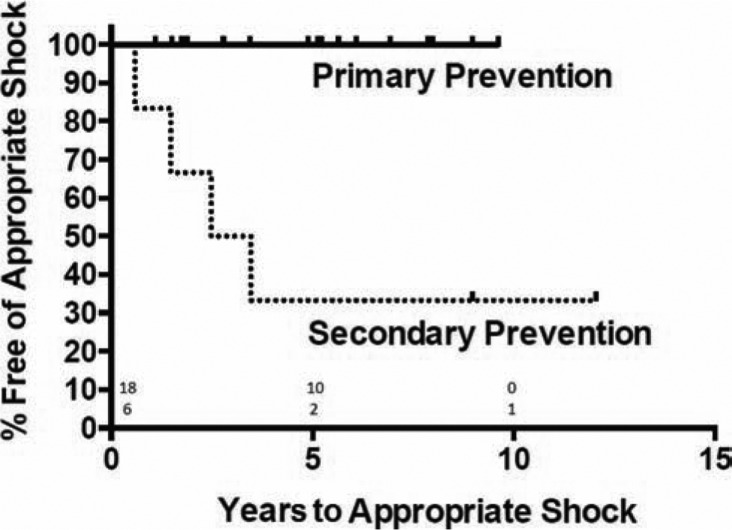
Time to appropriate shock following implantable cardioverter-defibrillators implantation. Median time to first shock for secondary prevention was 3.0 years (no events occurred in primary prevention arm), p = 0.002.